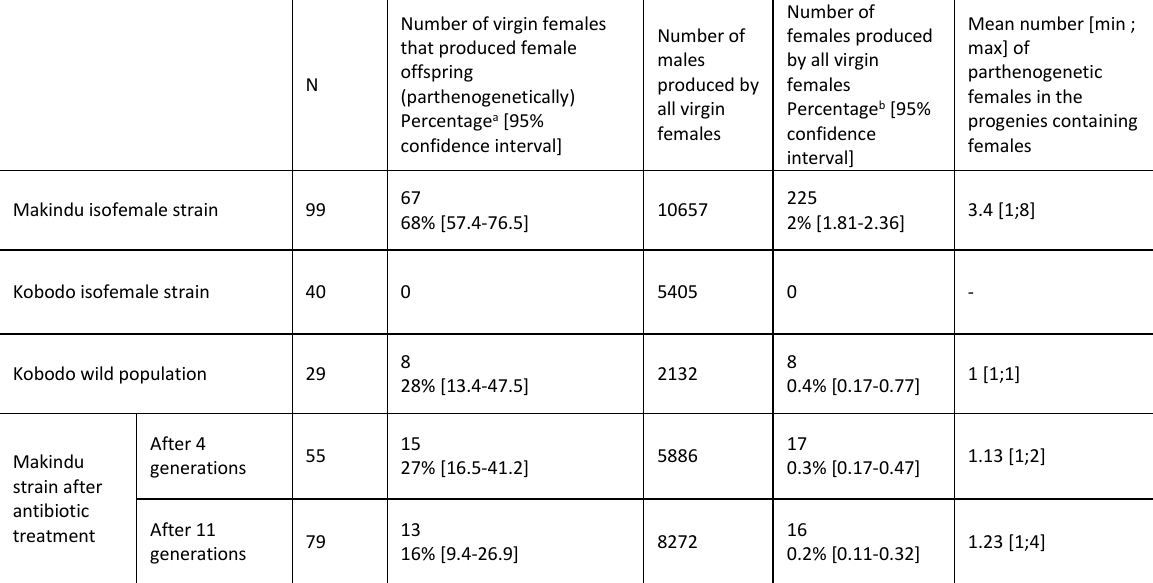
Table 1: Results of the thelytoky phenotyping of the different strains/populations. Number of virgin females that produced female offspring N (parthenogenetically) Percentage a